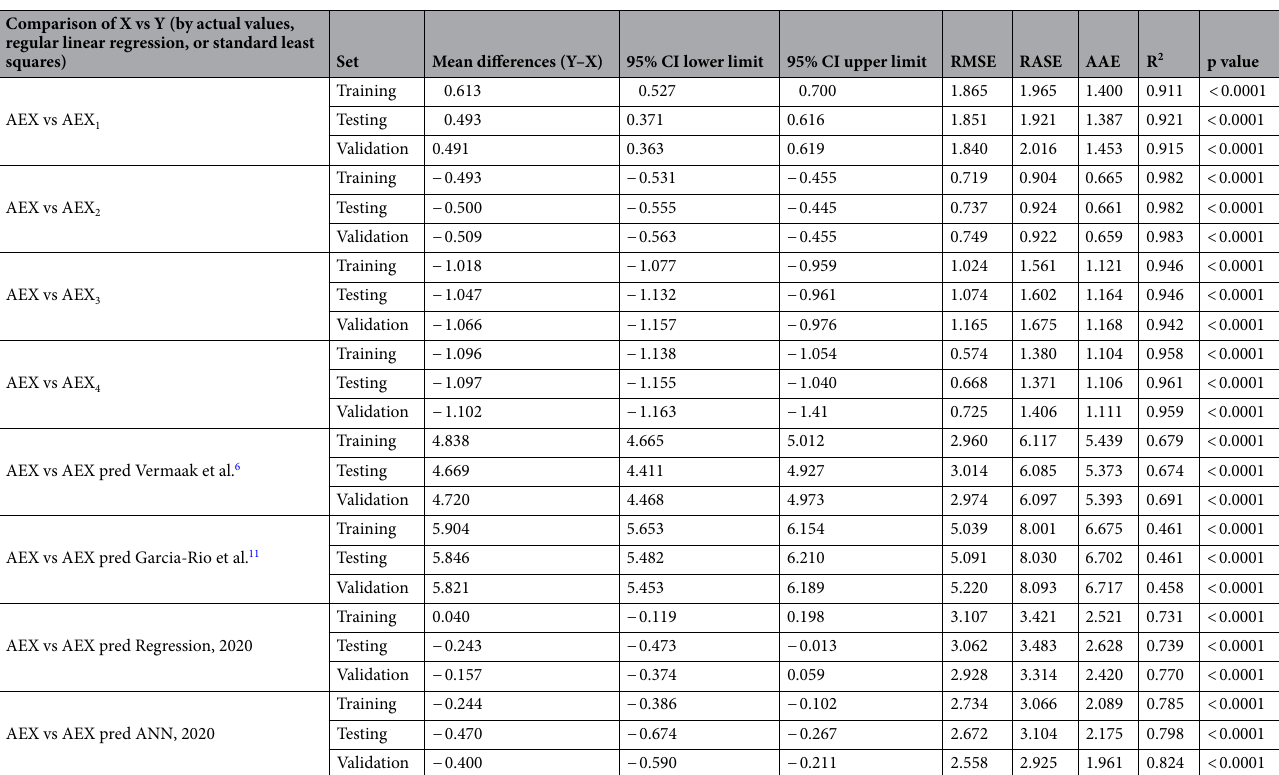
Table 2. Mean differences (with 95% Confidence Intervals, CI) between actual AEX, AEX approximations (AEX 1 through AEX 4 ) and predicted AEX values by four different formulas (Vermaak et al. 6 ; Garcia-Rio et al. 11 , regression and artificial neural networks or ANN, 2020) in the training, testing and validation sets. While the deviance (central tendency) seems slightly larger in the ANN-based model, the dispersion is smaller vs regression-based model using the same parameters (gender, race, age, height and weight), based on RMSE (Root Mean Square Error), RASE (square root of the mean squared prediction error, calculated as the square root of the sum of squares error divided by n) and AAE (average absolute